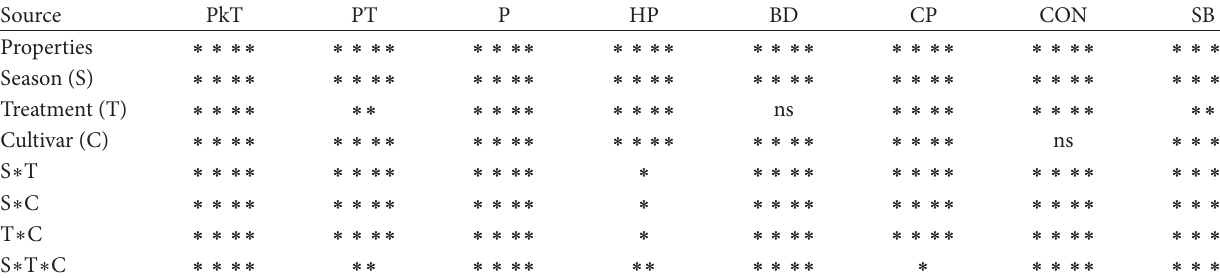
Table 2: 𝐹 -values for amylographic characteristics (cP) of rice cultivars influenced by agricultural practice in two crop seasons.